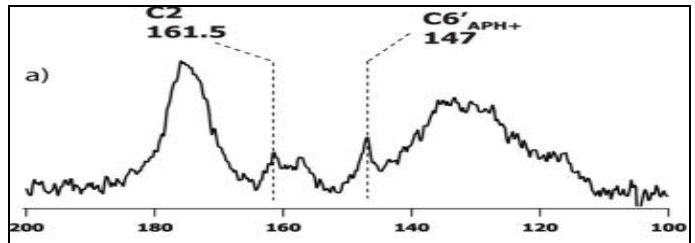
Figure 3. 13 C CPMAS SSNMR spectra of E1o reconstituted with [C2,C6 ′ - 13 C ( a ) Spectrum acquired at pH 7.0 at 8 °C with 32,768 transients. ( b ) Spectrum acquired at pH 8.0 at 10 °C with 28,900 transients. Recycle delay was 5 s for acquiring both spectra. (Bottom). Representative near-UV CD spectra of E1o at varying pH values. E1o (5 mg/mL) in 2.4 mL of a triple buffer (15 mM MES, 15 mM KH containing additional 0.5 mM ThDP and 2.5 mM Mg 2+